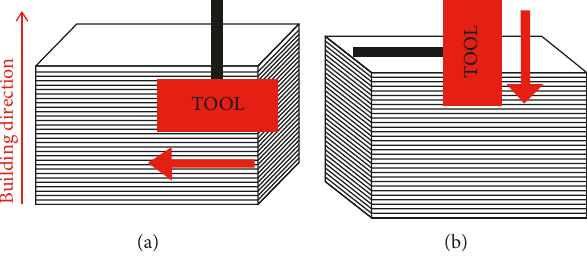
Figure 4: Grinding directions. (a) Normal working direction. (b) Parallel working